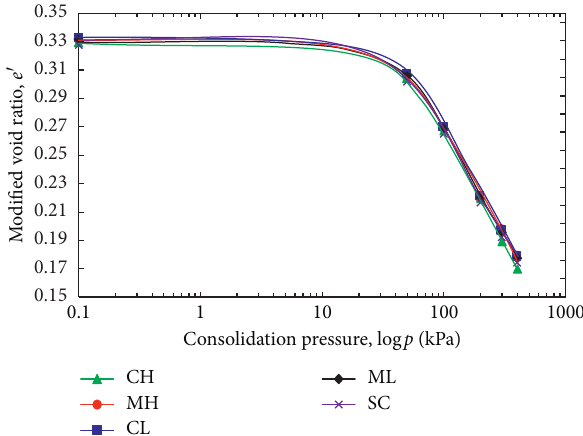
Figure 8: Compressive behavior of saturated soils with the same initial modified void ratio.